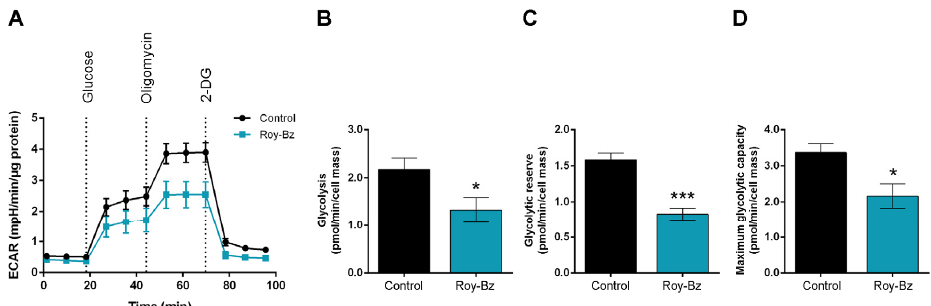
Figure 5. Roy-Bz inhibits the glycolytic pathway capacity in colon cancer cells. HCT116 cells were treated with 0.5 μ M Roy-Bz or vehicle (DMSO), for 48 h. ( A ) ECAR curves were assessed with a